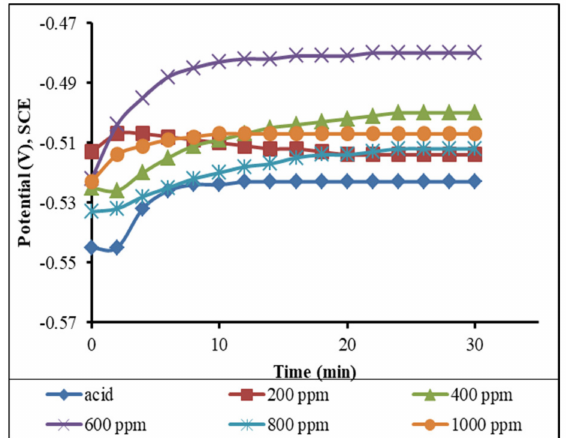
Figure 14. Variation of the OCP with the time of immersion of the mild steel in the different concentrations of inhibitors in the 1 M H 2 SO 4 solution (measured at the time of immersion).